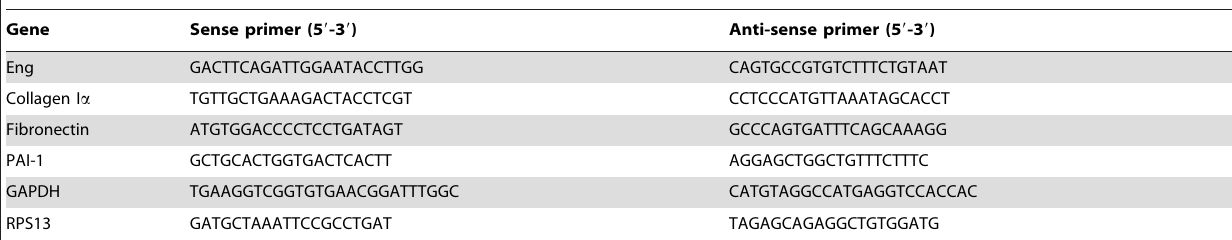
Table 1. Sequences of primers.